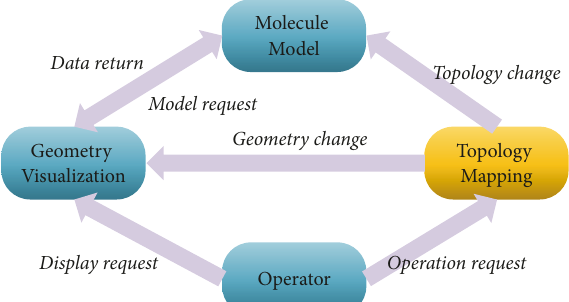
Figure 19: MVO based system framework.